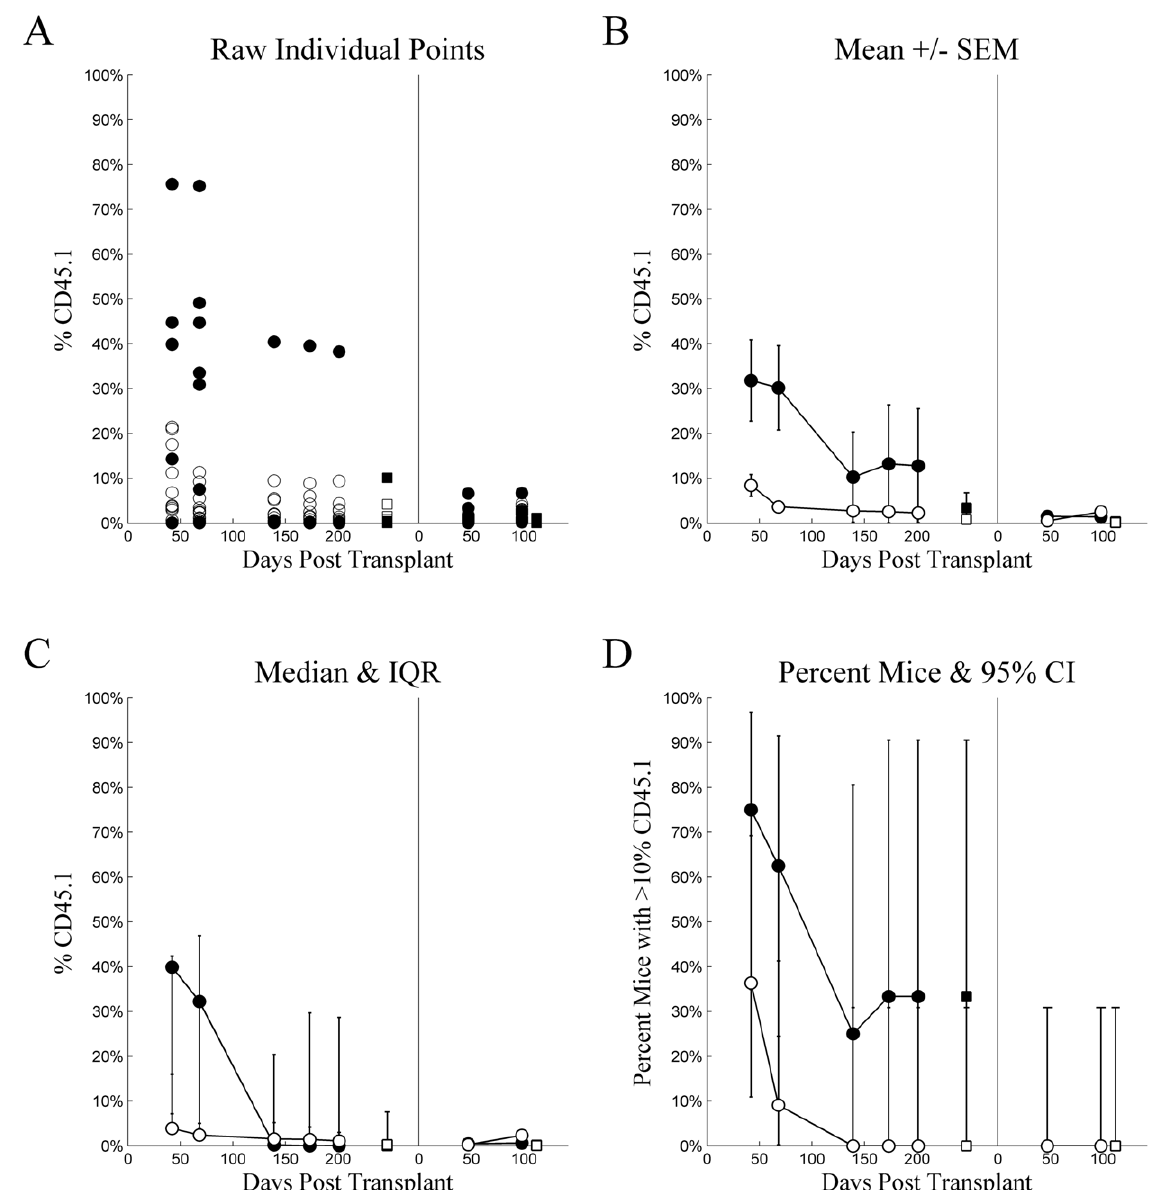
N N Figure 7. Experiment 3: intrafemoral injection. Chimerism (%CD45.1) (ordinate) plotted as a function of Days Post Transplant (abscissa), type of & : LT-HSC, #% : ST-HSC), and source ( # : whole blood, &% : whole bone marrow) for several different methods of summary: A) cells injected ( raw individual mouse percent CD45 cells that were CD45.1, B) mean 6 standard error of the mean, C) median with inter-quartile range, and D) percent of mice with greater than 10% of CD45 cells being CD45.1. For each tile, the data from the primary transplant is plotted on the left and secondary transplant on the right, separated by a vertical line at zero for the secondary transplant.